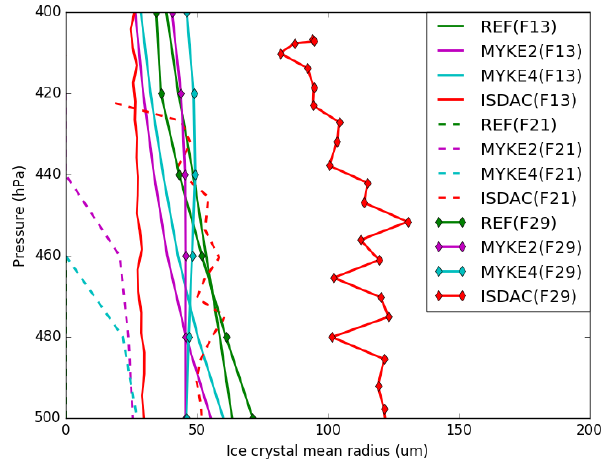
Figure 8. Comparison of the observed (red) and simulated (REF in green, MYKE2 in purple and MYKE4 in cyan) R i along flights F13 (solid lines), F21 (dashed lines) and F29 (solid line with diamond